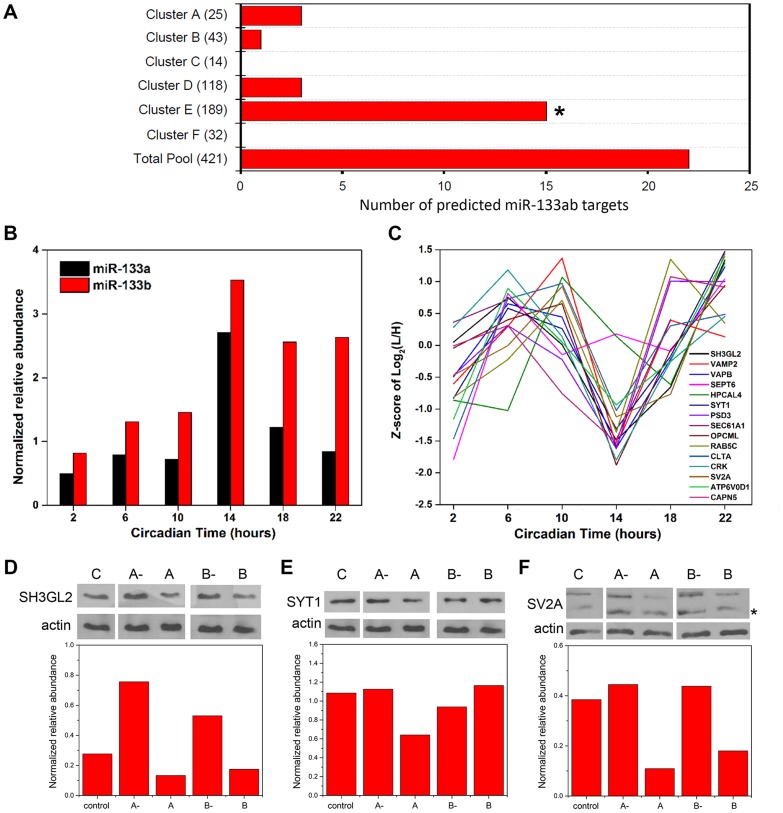
Functional implications for miRNA target enrichment in specific hierarchical clusters.(A) Distribution of the number of predicted miR-133ab murine target genes in the six hierarchical clusters. Compared to other hierarchical clusters, cluster E was significantly enriched for predicted murine targets of miR-133ab (Fisher's exact test, p<0.05). (B) Expression profiles of miR-133a and miR-133b, along with (C) those of their respective protein targets in cluster E. qRT-PCR was performed to detect and measure the relative abundance of miR-133a and miR-133b in the SCN. Information regarding predicted miRNA targets was extracted from the broadly conserved microRNA families from the TargetScanMouse database. (D–F) Western blot analysis of three predicted miR-133ab targets in cluster E, including (D) SH3GL2, (E) SYT1, and (F) SV2A, in Neuro2A cells transfected with either microRNA inhibitors against miR-133a (A-) or miR-133b (B-), microRNA mimics for miR-133a (A) or miR-133b (B), or microRNA inhibitor negative controls (C). Actin was used as the loading control in Western blot analysis. Values in each graph represent the median relative abundance of the protein examined normalized to actin expression (n = 3 per CT). The asterisk (*) denotes the presence of a faster-migrating, non-specific band.